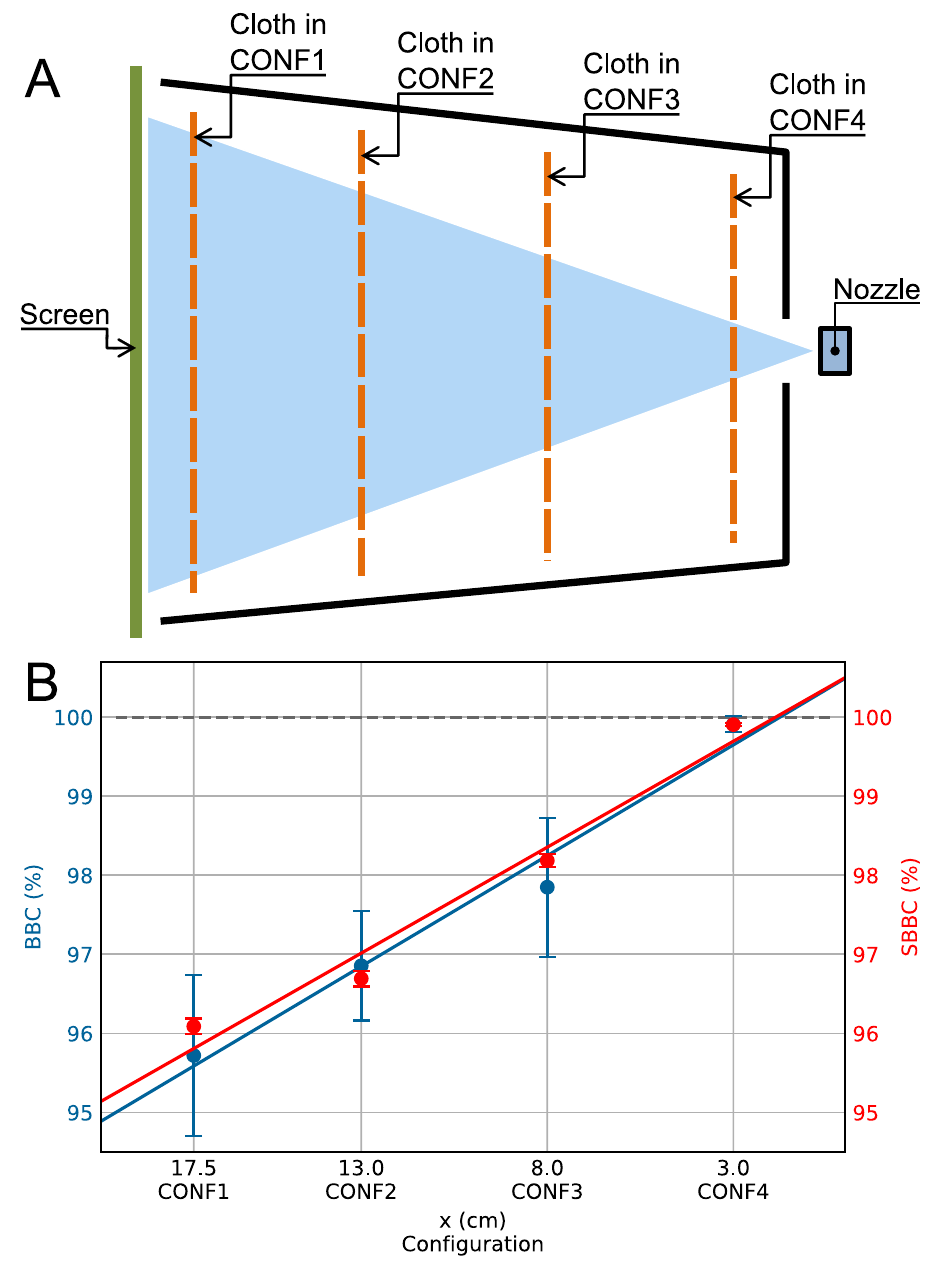
Fig 6. BBC and SBBC for intermediate positions of the blocking material. (A) Sketch of the cloth positions under study. (B) Experimental (BBC) vs. model (SBBC) results. Blue and red points correspond to experimental data and model calculations, respectively. Blue and red lines correspond to linear fits to the experimental and theoretical points, respectively.